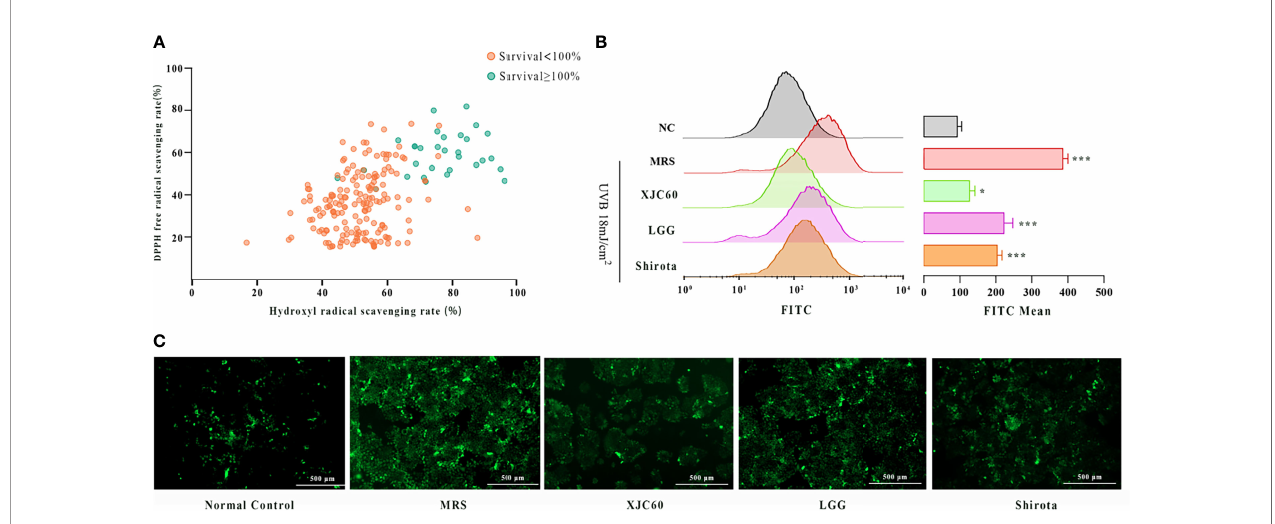
FIGURE 2 | In vitro antioxidant effects of lactic acid bacteria (LAB) strains. (A) DPPH and hydroxyl radical-scavenging activities of minimum nontoxic dilutions (MNTDs) for the 206 LAB strains. (B) Reactive oxygen species (ROS) levels of different MNTDs in UVB-injured HaCaT cells, as examined by fl ow cytometry. (C) Fluroescence images of ROS staining for MNTD-treated UVB-injured HaCaT cells. All data are presented as means ± SDs (n = 3). * P < 0.05, *** P < 0.001 compared with the normal control (NC)